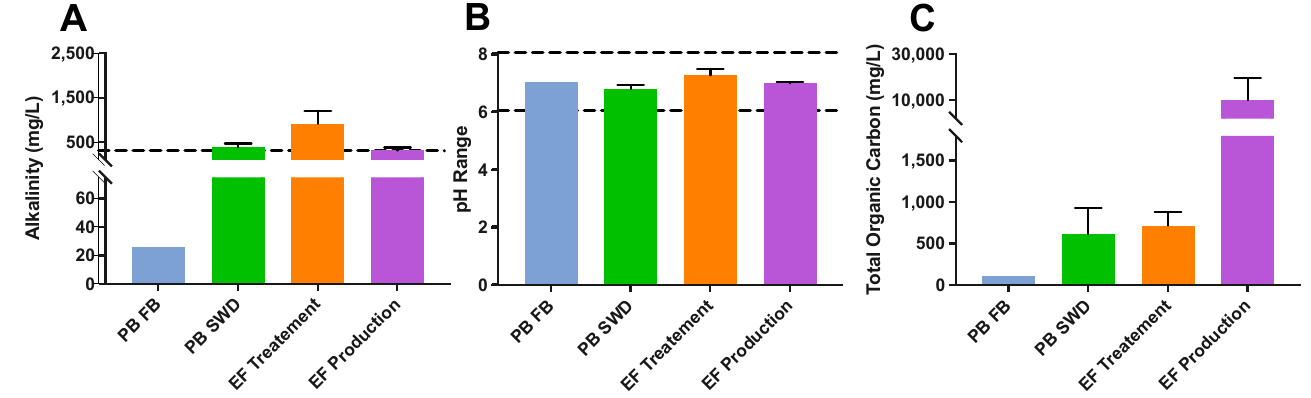
shows alkalinity was only 26 mg/L for the PB FB but ranged from 74 to 840 mg/L for the PB SWD samples. The samples from the EF treatment facility had a similar range, from 170 to 910 mg/L for 11 of the 13 samples, with the remaining 2 reaching as high as 2200 and 4000 mg/L, respectively.